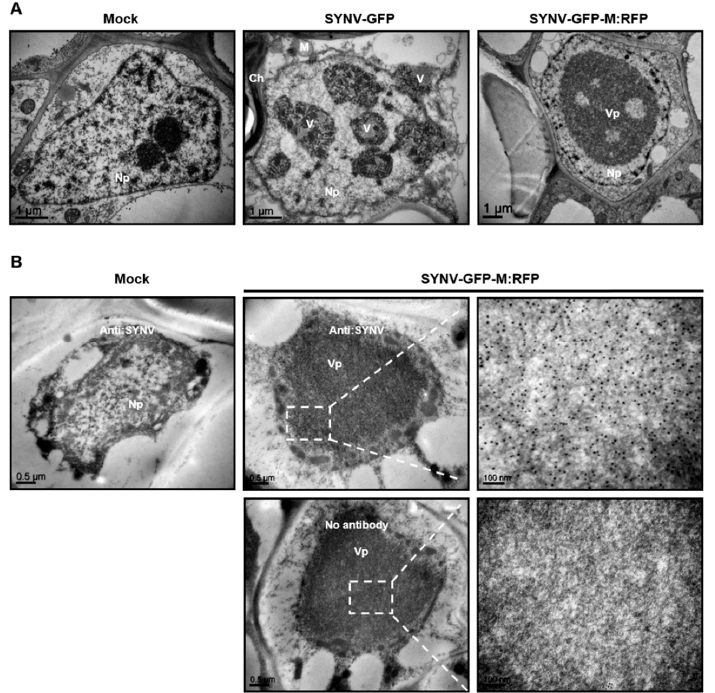
Figure 5. Cytopathology elicited by SYNV ‐ GFP ‐ M:RFP infections. ( A ) Electron micrographs of ultrathin sections of N. benthamiana plants mock infected, infected with SYNV ‐ GFP or SYNV ‐ GFP ‐ M:RFP. ( B ) Representative electron micrographs showing immunogold ‐ labeled viroplasms in SYNV ‐ GFP ‐ M:RFP infected nuclei. Ultrathin sections were first incubated in buffer with or without primary polyclonal antibodies raised against disrupted SYNV virion (anti ‐ SYNV) and then with secondary anti ‐ IgG antibody conjugated with gold particles. Boxed regions are enlarged on the right panels to highlight the distribution of gold particles. Ch: chloroplast; M: mitochondria; Np: nucleoplasm; V: virion; Vp: